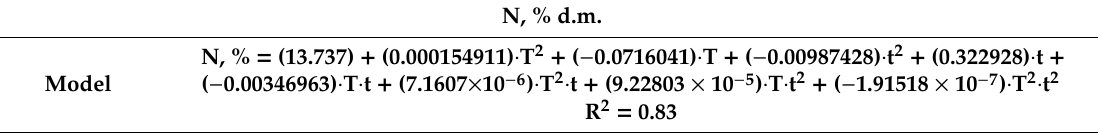
Table A14. The statistical parameters of polynomial regression analysis of the influence of SS torrefaction temperature and residence time on the N content in biochars.